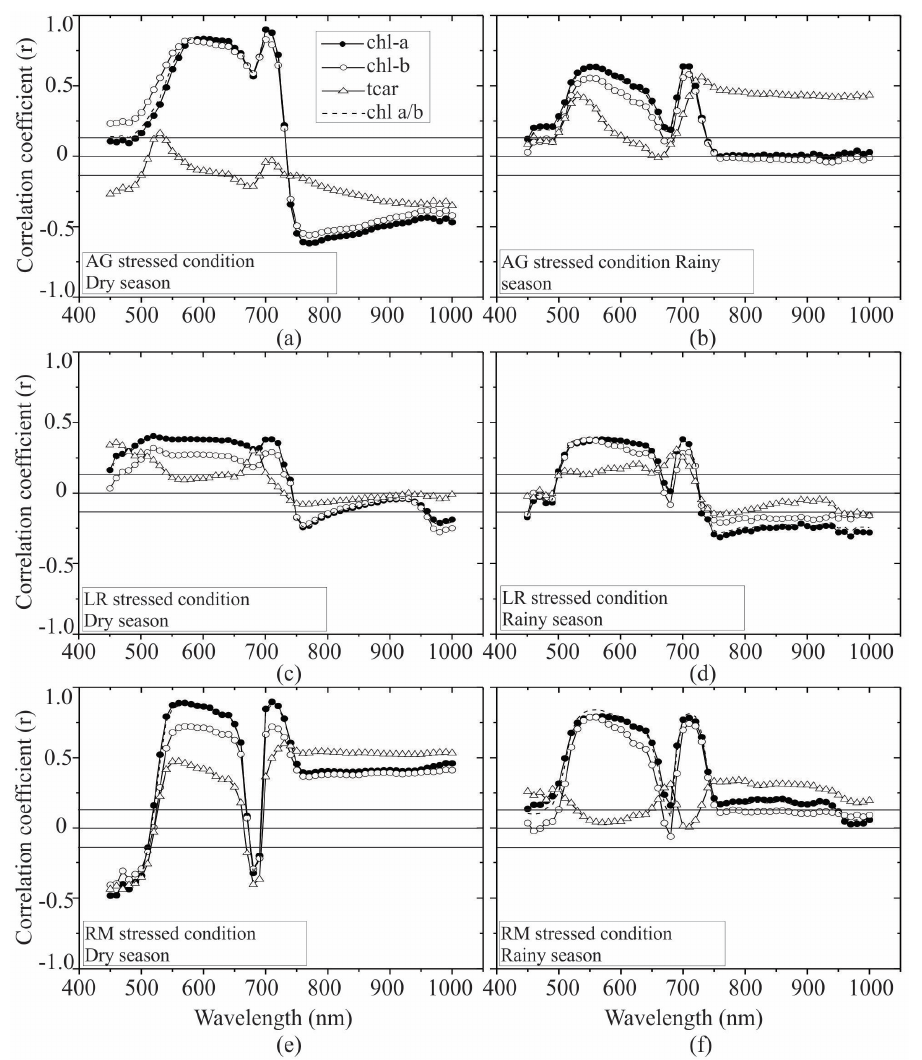
Figure 5. Correlograms of leaf pigments and pseudo-absorption of mangroves under stress condition for the dry and rainy seasons. Avicennia germinans (AG), Laguncularia racemosa (LR), and Rhizophora mangle (RM). The horizontal lines at ±0.12 correlation indicate the 95% confidence limits. Chl-a overlaps the chl a/b ratio line. ( a )AG dry season; ( b ) AG rainy season; ( c ) LR dry season; ( d ) LR rainy season; ( e ) RM dry season; ( f ) RM rainy season.